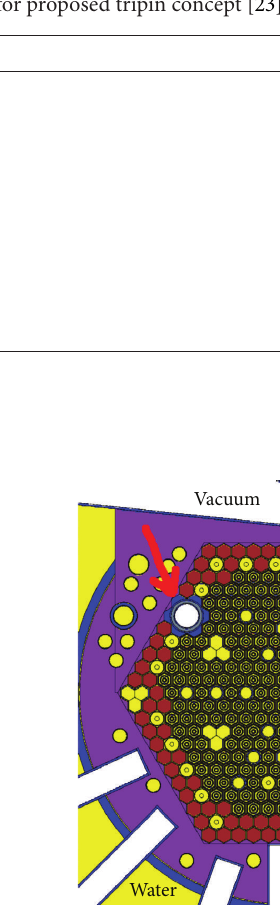
Figure 22: The geometry of the B shield (marked by the red arrow) inside BRR